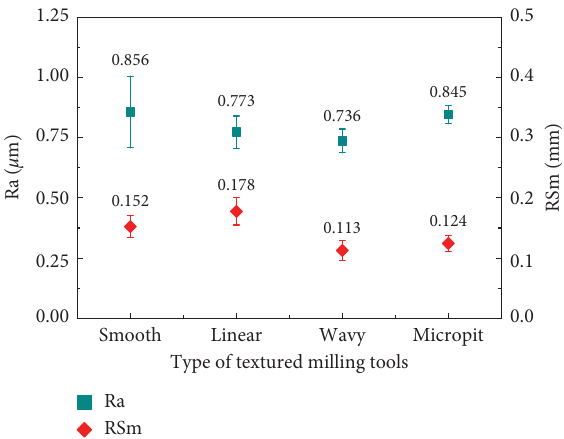
Figure 10: Roughness of the workpiece under different textured tools.